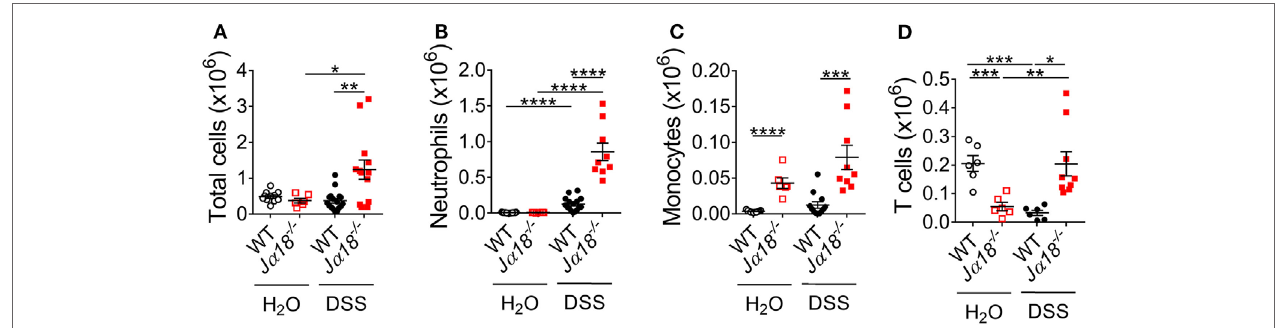
FigUre 4 | Changes in leukocyte populations following dextran sodium sulfate (DSS)-induced colitis in wild type (WT) and J α 18 − / − mice. (a) At day 7, total leukocyte numbers from colon of WT and J α 18 − / − mice were counted. (B–D) Cells were stained with fluorochrome-conjugated antibodies against CD45, CD3, Ly6C, and Ly6G. The number of (B) Ly6G + neutrophils, (c) Ly6C hi Ly6G − monocytes, and (D) CD3 + T cells were analyzed by flow cytometry. n ≥ 6. Data represent mean ± SEM. Student’s t -test was performed. Significance is represented by * p < 0.05, ** p < 0.01, *** p < 0.001, and **** p < 0.0001. These data were obtained from at least two independent